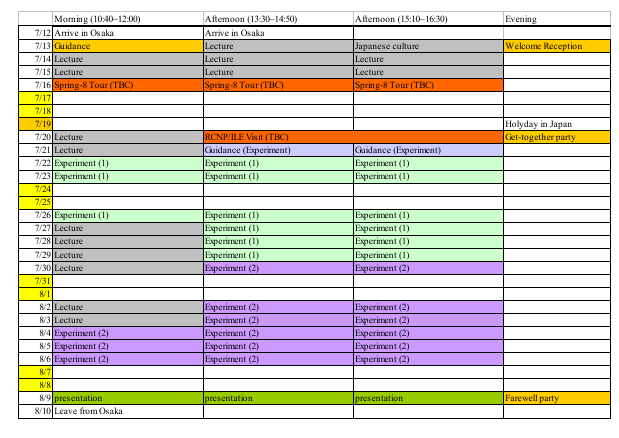
Fig. 1. Schedule in